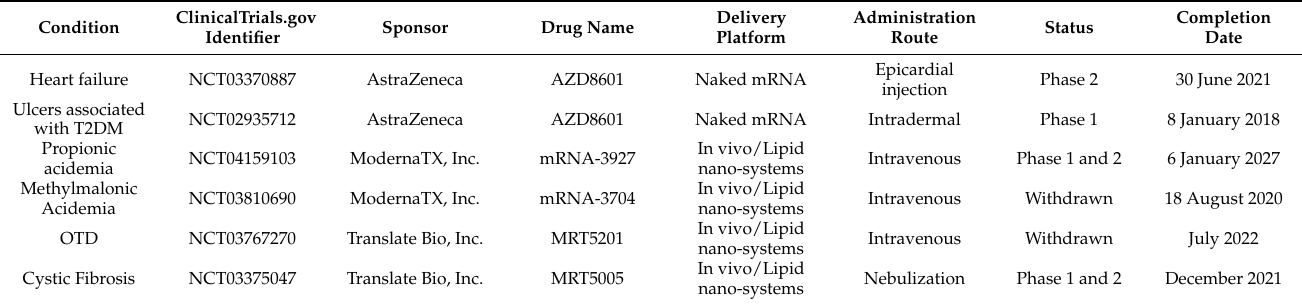
Table 1. Clinical trials that use mRNA technology for protein replacement in various diseases (accessed in September 2022). T2DM, type 2 diabetes mellitus; OTD, ornithine transcarbamylase